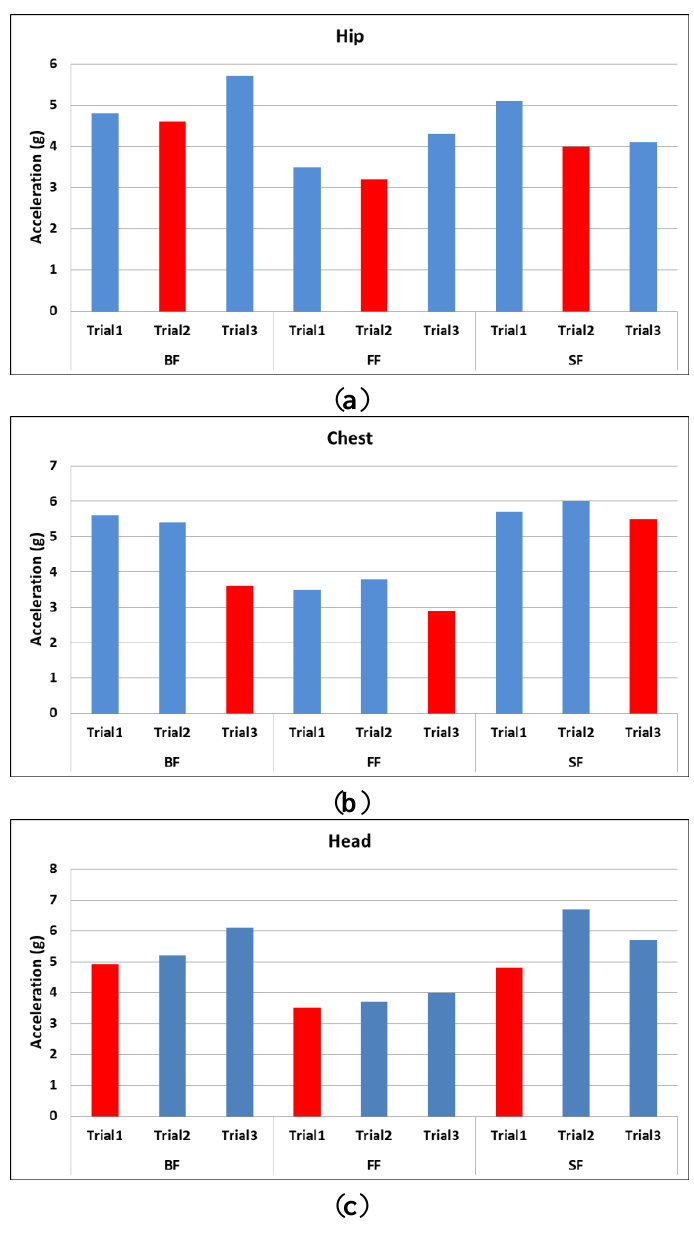
Figure 6. Peak values of three different trials in the normal direction for forward fall (FF), backward fall (BF) and side fall (SF) for the hip, chest and head